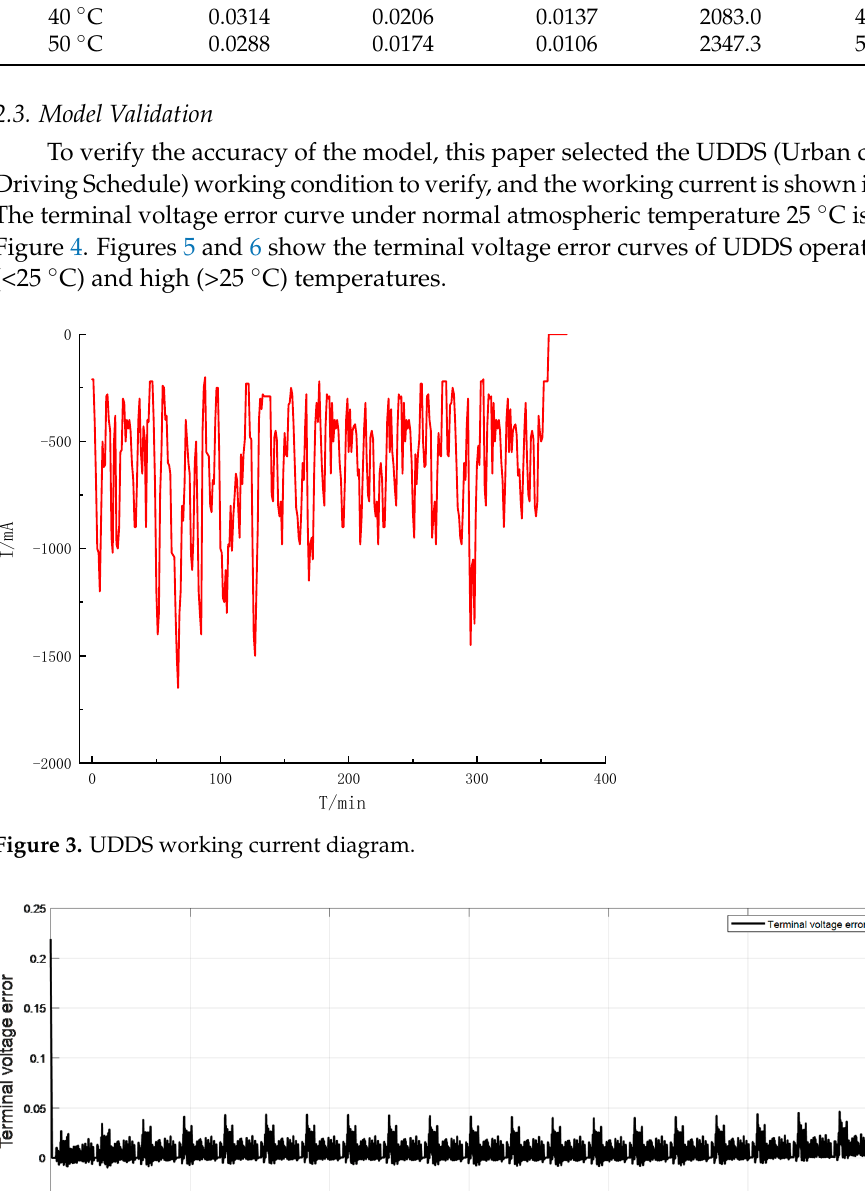
Figure 5. Terminal voltage error curve at low temperature. Figure 6. Terminal voltage error curve at high temperature. Compared with the working current waveform of UDDS, the terminal voltage error at the small current section (current ≤ 1A) is mostly maintained at ±100 mV, and the volt- age error at the large current section (current > 1A) can reach 150–200 mV. It can be seen from Figure 5 that the terminal voltage error at − 10 °C fluctuated greatly, and the terminal voltage error of 0 °C was greatly improved, which can maintain ±50 mV in the small cur- rent section, and the error range is 50–100 mV in the large current section. As shown in Figure 6, when the ambient temperature is more than 25 °C, the fluctuation range of